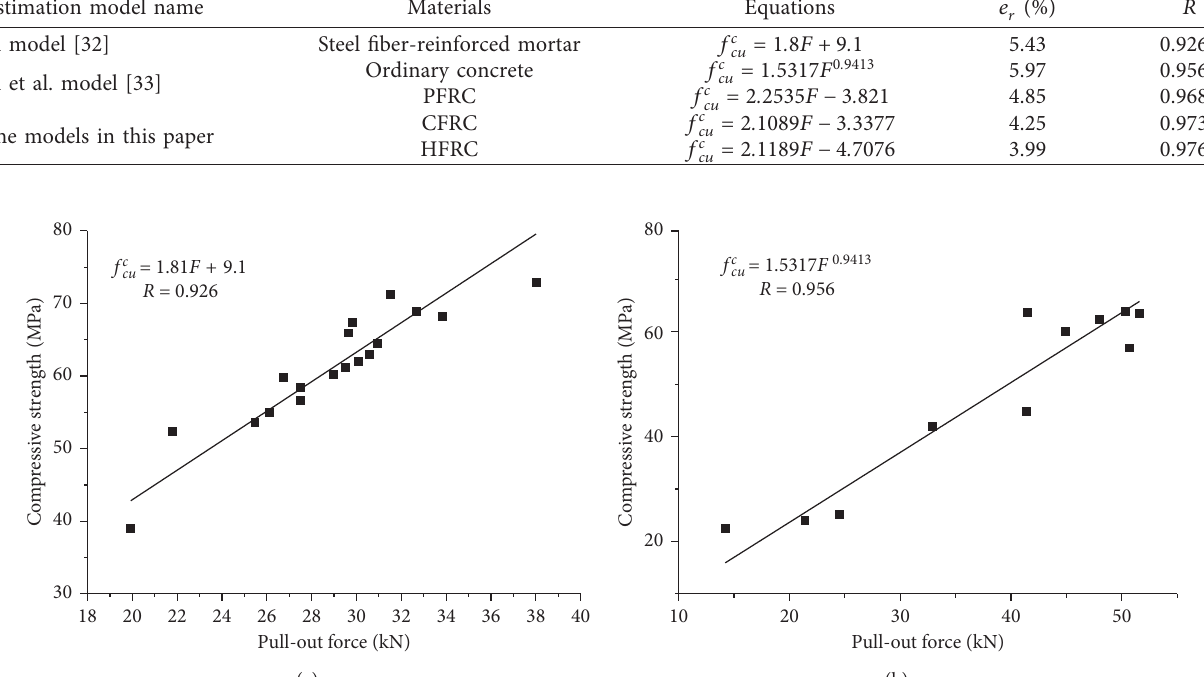
Figure 6: Relationship between the pull-out force and compressive strength obtained by the two different models in the postinstalled pull- out test. Strength curves of (a) the Li model and (b) the Li et al.